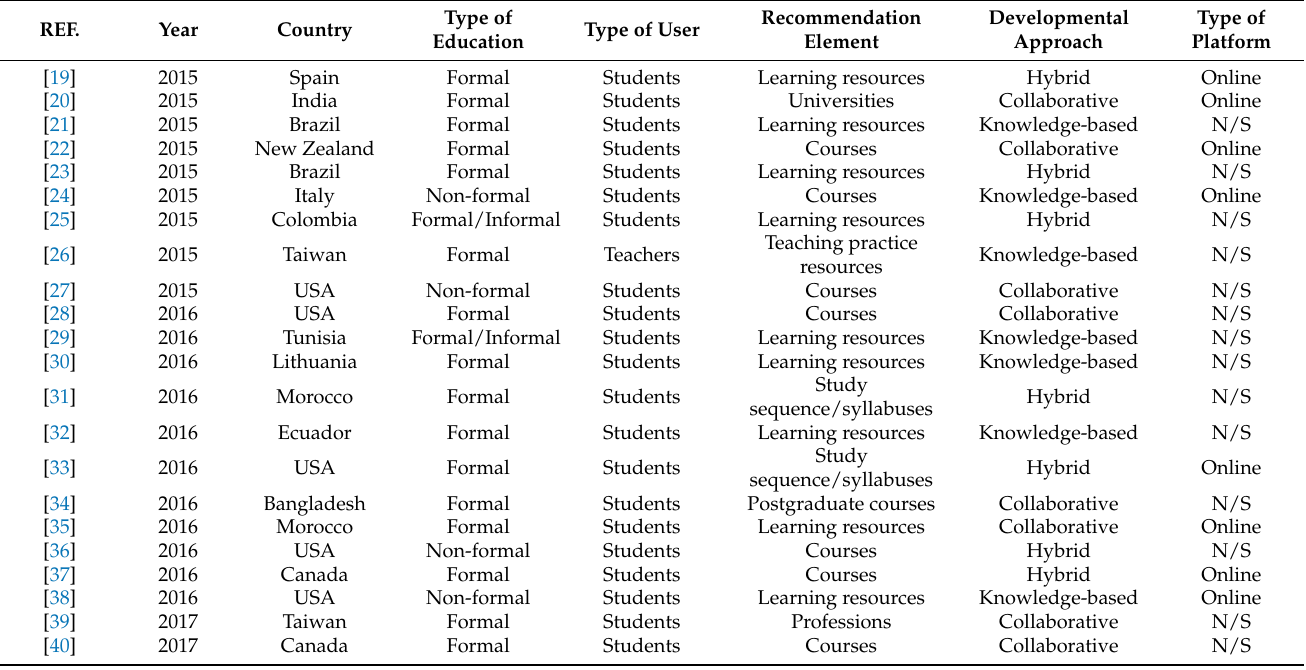
Table A1. Articles include in the systematic